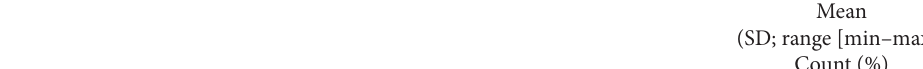
Table 1: Participant’s characteristics and